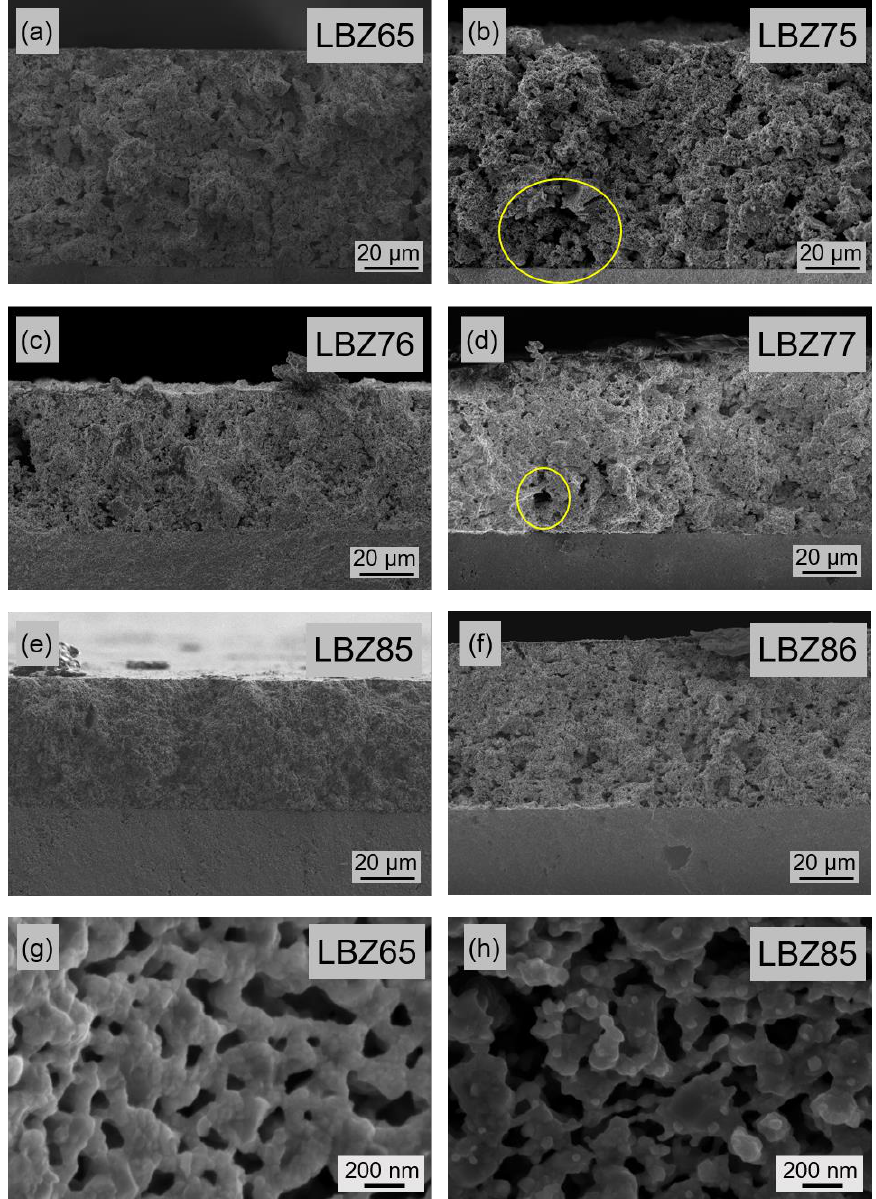
Figure 6. ( a ) to ( f ) Scanning electron microscopy (SEM) micrographs of tested LBZ cathodes in symmetrical cell configuration prepared at 1100 ◦ C. The cells were tested by electrochemical impedance spectroscopy (EIS) from 400 to 600 ◦ C in 3% moist synthetic air. Inhomogeneities in the cathodes are highlighted in yellow. High magnification micrographs of web-like microstructure of LBZ65 ( g ) and LBZ85 ( h ) cathodes after electrochemical testing.